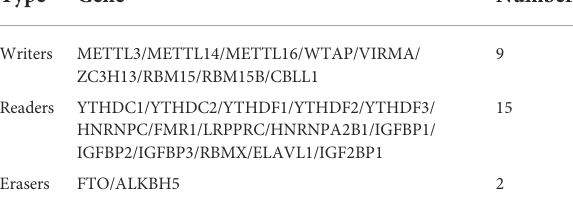
TABLE 1 The characteristics of 26 m6A